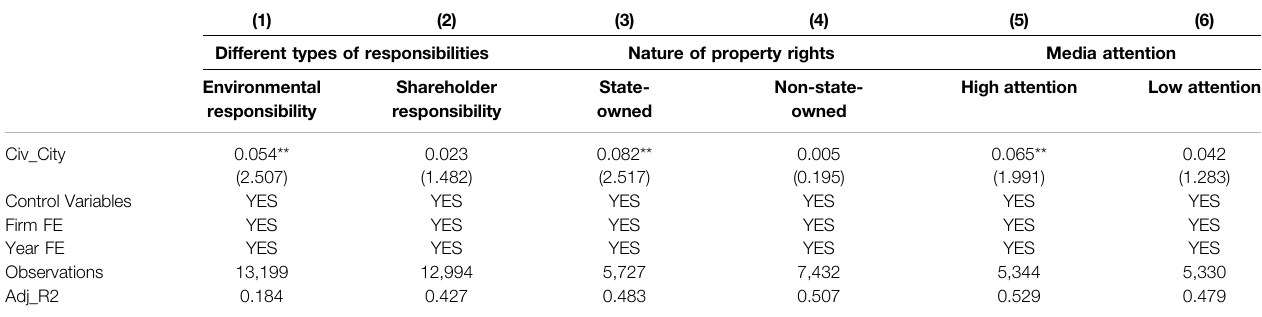
TABLE 2 | Heterogeneity